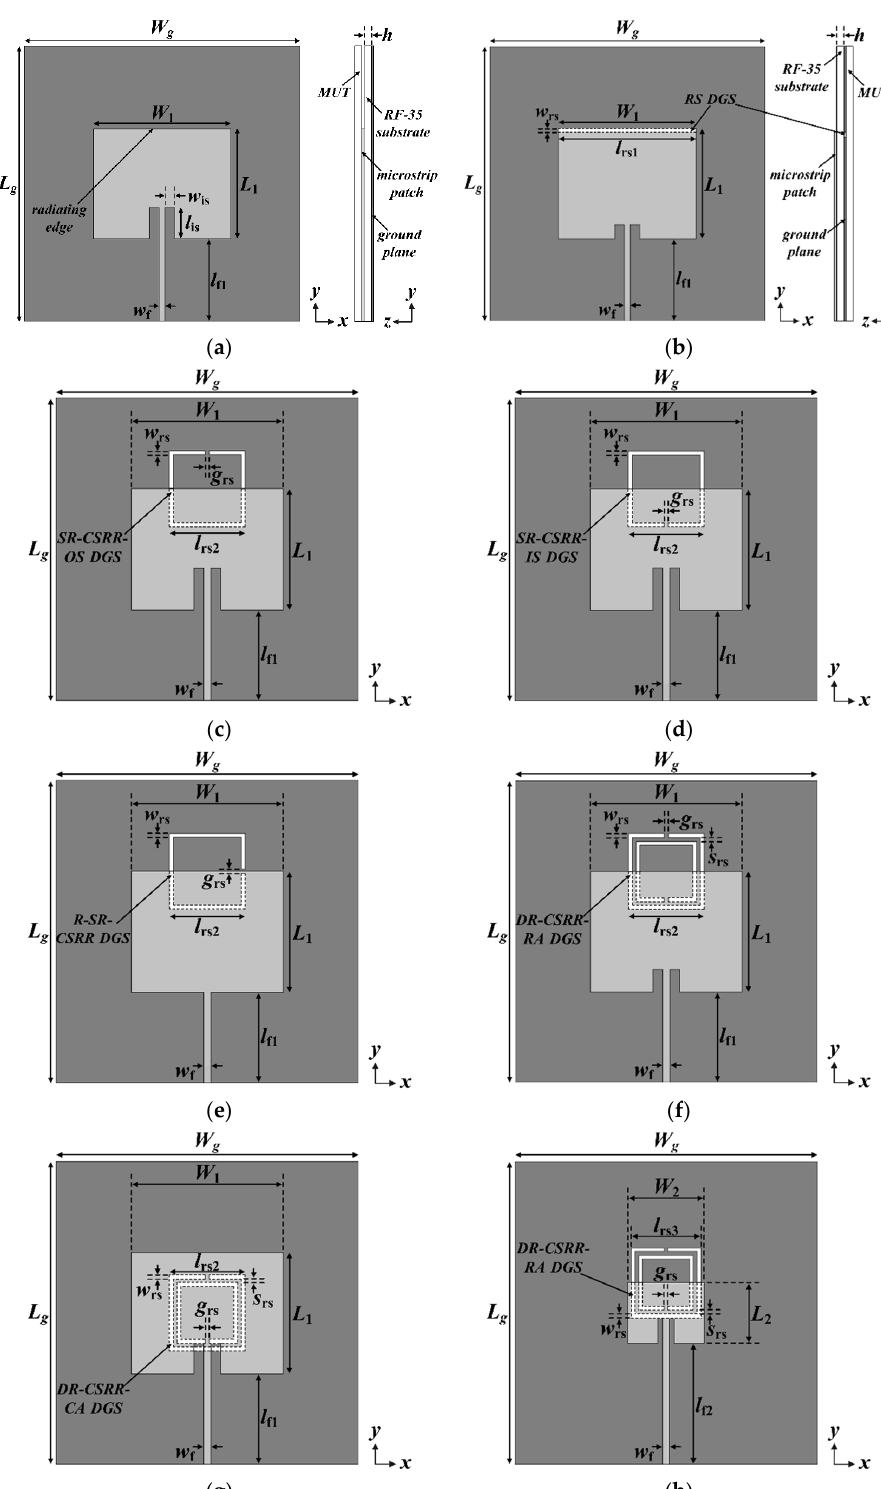
Figure 1. Geometries of the microstrip patch sensor antennas (MPSAs): ( a ) a conventional MPSA without a defected ground structure (DGS); ( b ) an rectangular slit (RS) DGS-loaded MPSA; ( c ) an SR-CSRR outside split (SR-CSRR-OS) DGS-loaded MPSA; ( d ) an SR-CSRR inside split (SR-CSRR-IS) DGS-loaded MPSA; ( e ) a 90-degree rotated SR-CSRR (R-SR-CSRR) DGS-loaded MPSA; ( f ) a DR-CSRR radiating edge aligned (DR-CSRR-RA) DGS-loaded MPSA; ( g ) a DR-CSRR center aligned (DR-CSRR-CA) DGS-loaded MPSA; and ( h ) the proposed scaled DR-CSRR-RA DGS-loaded